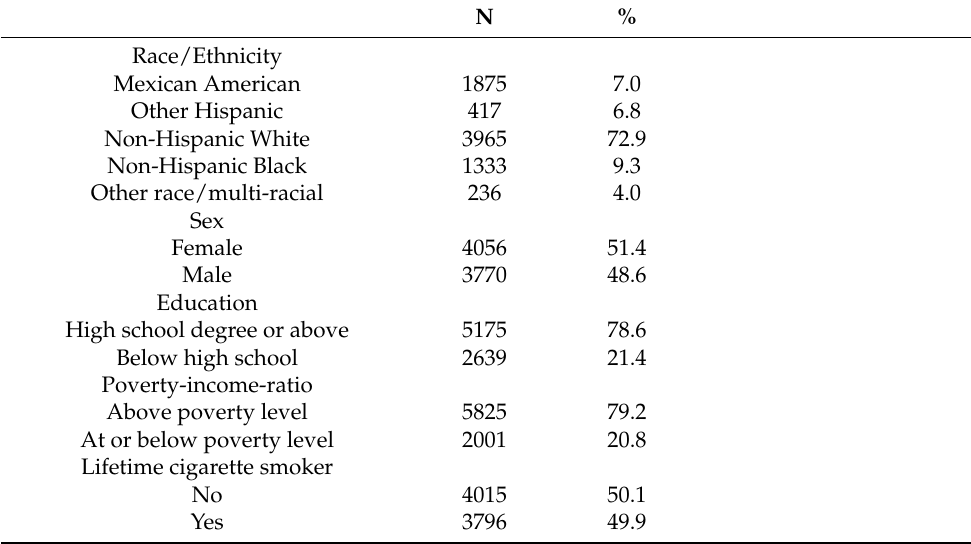
Table 1. Sample sociodemographic variables (N =